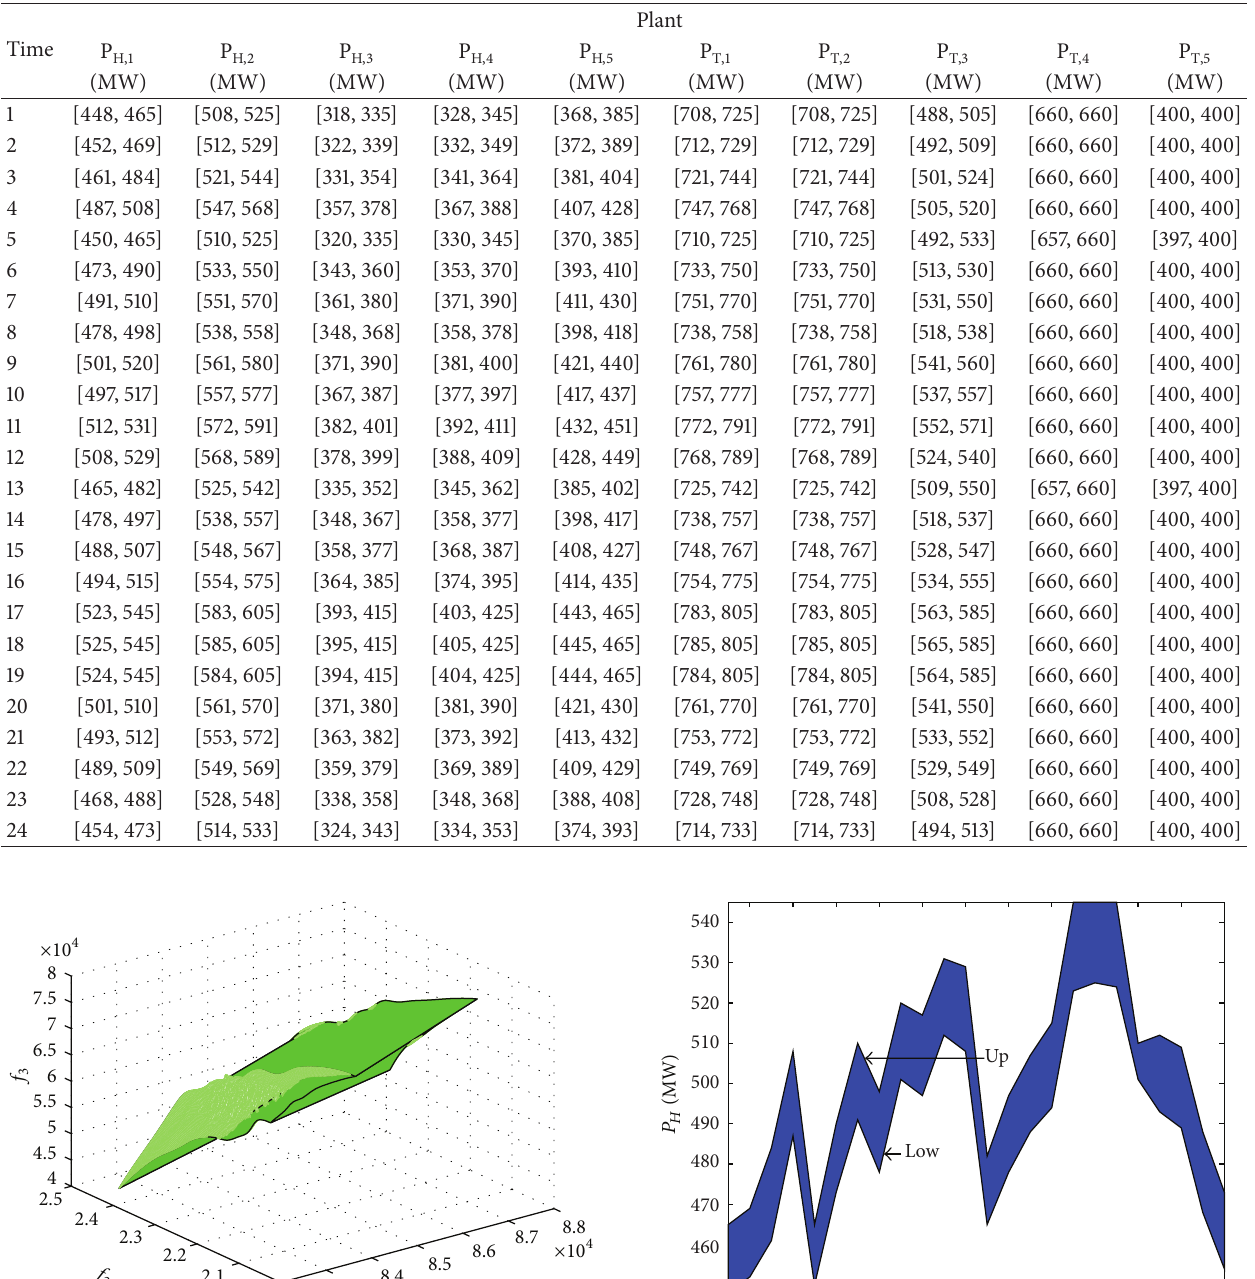
Table 3: The optimal output range of all power plants.